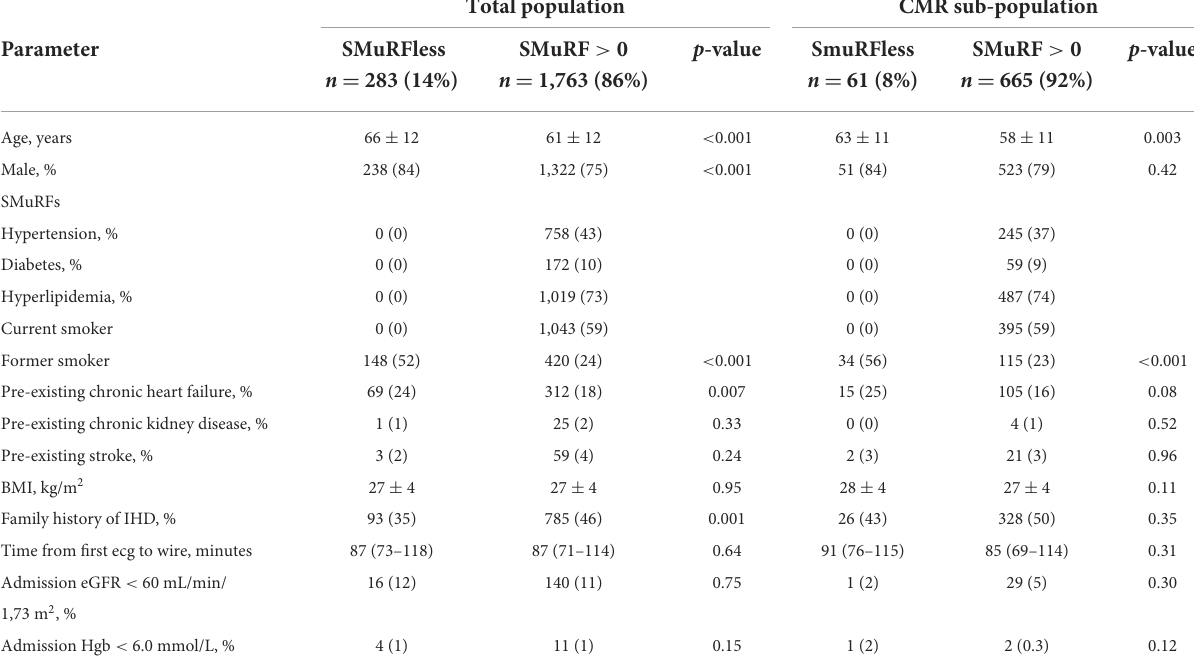
TABLE 1 Baseline characteristics between SMuRFless and patients with more than one SMuRF, total DANAMI-3 and CMR